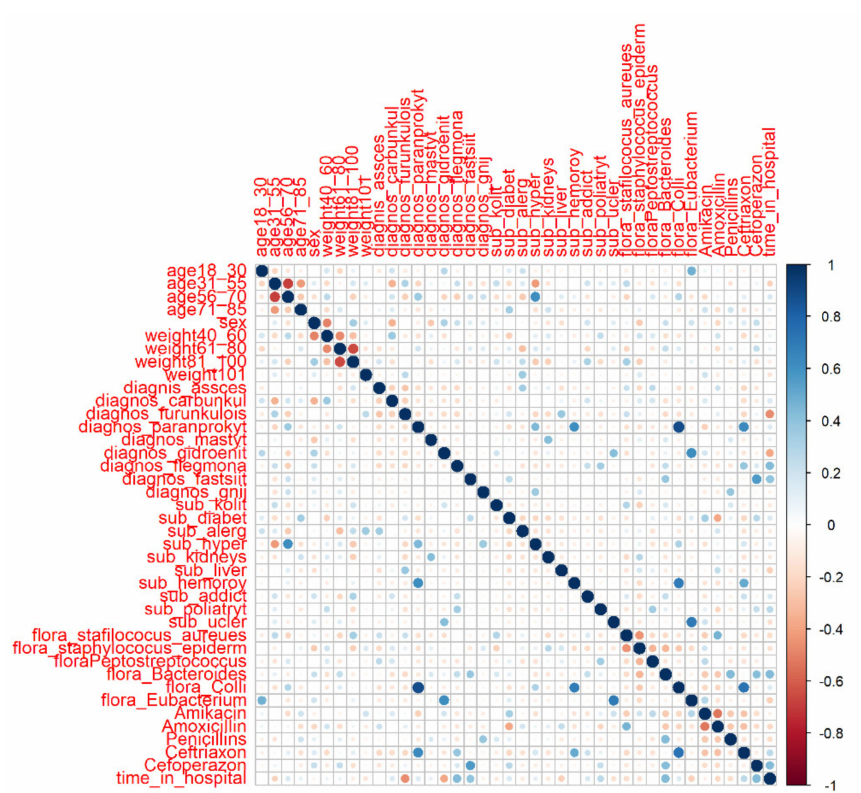
Figure 6. Correlation matrix. Significant correlation is